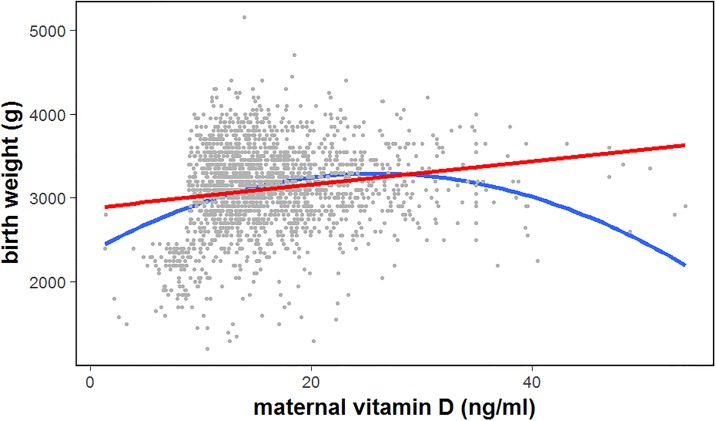
Scatter plot of correlation between maternal 25(OH)D level during pregnancy and neonatal birth weight (r = 0.522, P<0.001).Both the estimated regression line (red line) and a true curve line (blue line) demonstrate the inverse association between these two variables.